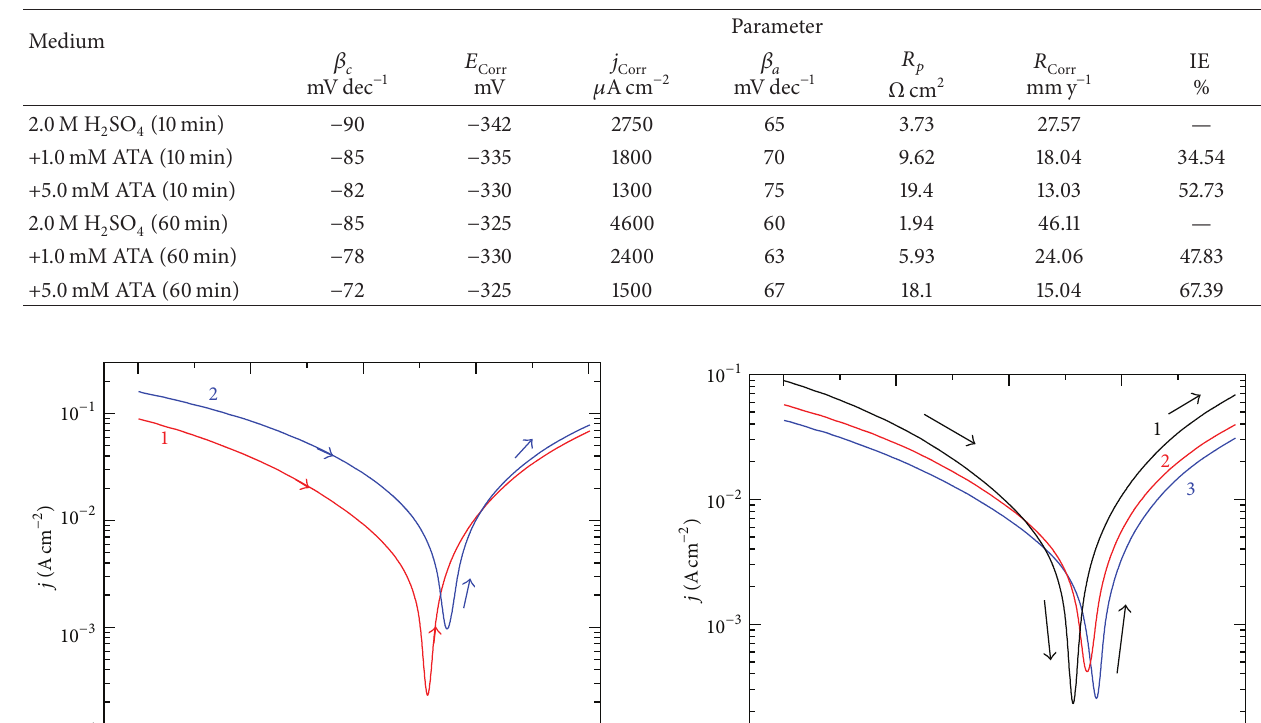
SO solutions with and without ATA molecules. 2 4